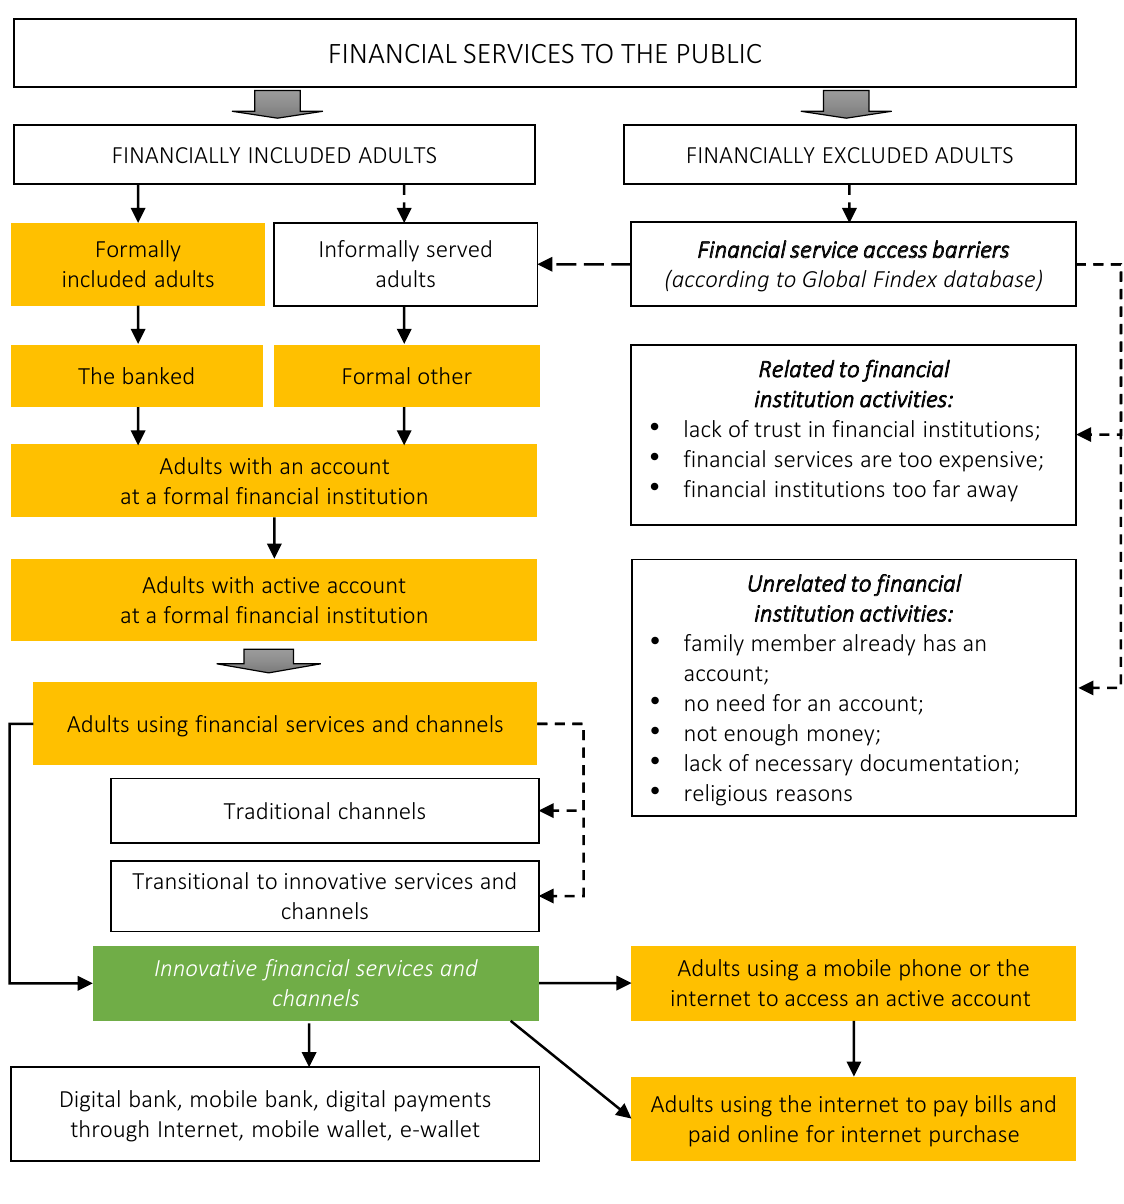
Figure 2. The sequence of analyzing the level of digital financial inclusion based on the G20 Financial Inclusion